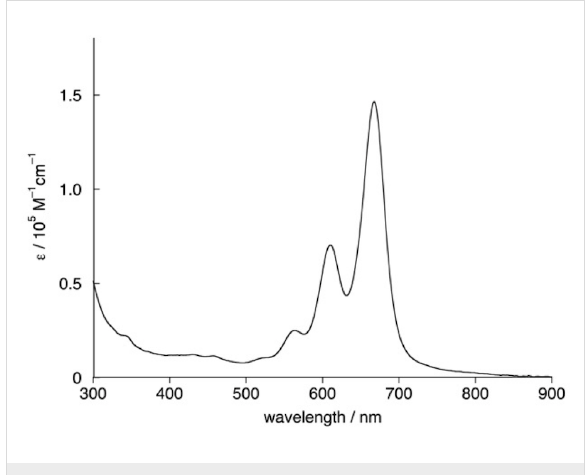
Figure 5: UV–vis absorption spectrum of QB4 in toluene.